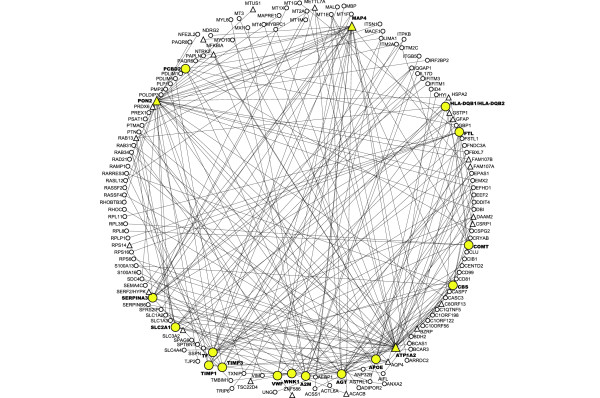
Sub-network in module 1 illustrating the 18 disease associated genes and their connections. This sub-network shows the 18 disease associated genes (colored yellow) and the genes that they are connected to within module 1. The hub genes are represented as triangle nodes. Disease genes MAP4, PON2 and ATP1A2 were also hub genes. Only the hub genes that connect to disease genes are shown here. Module 1 consists of 22 hub genes in total.